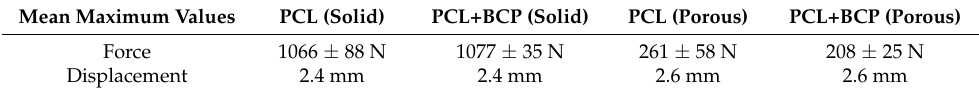
Figure 1. Force-displacement curves of ( A ) solid scaffolds and ( B ) porous scaffolds. Table 1. Force and displacement applied onto bulk and porous scaffold